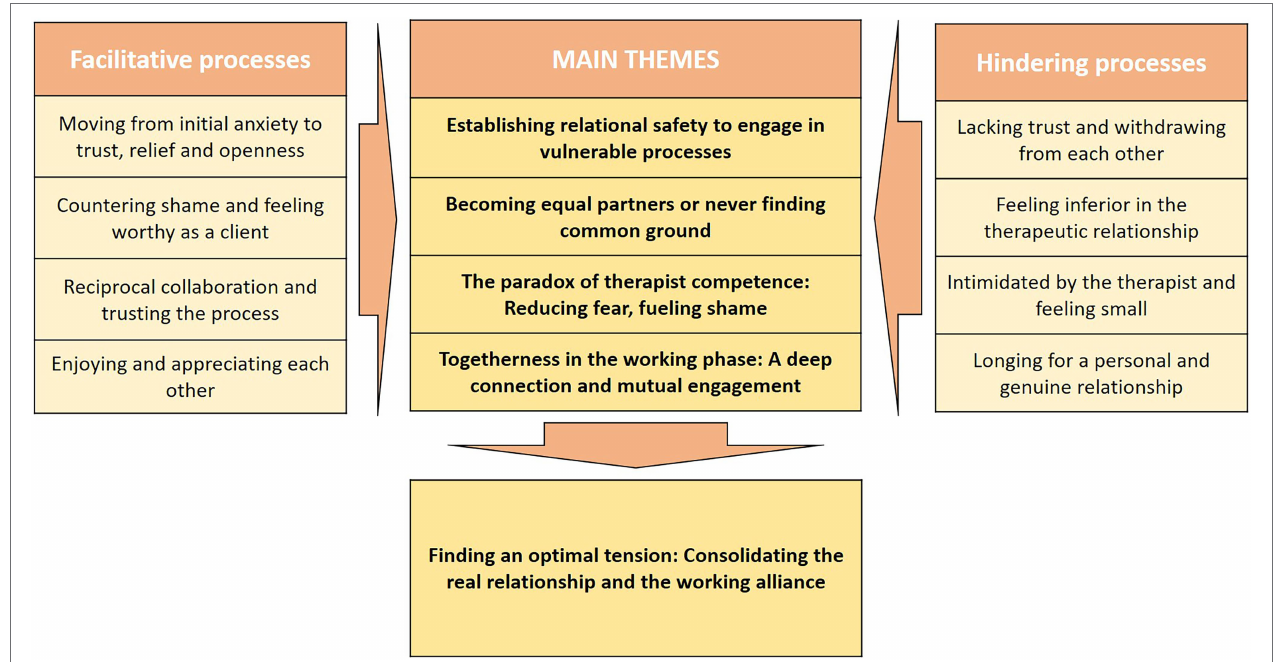
FIGURE 1 | Illustration of main themes and contributing